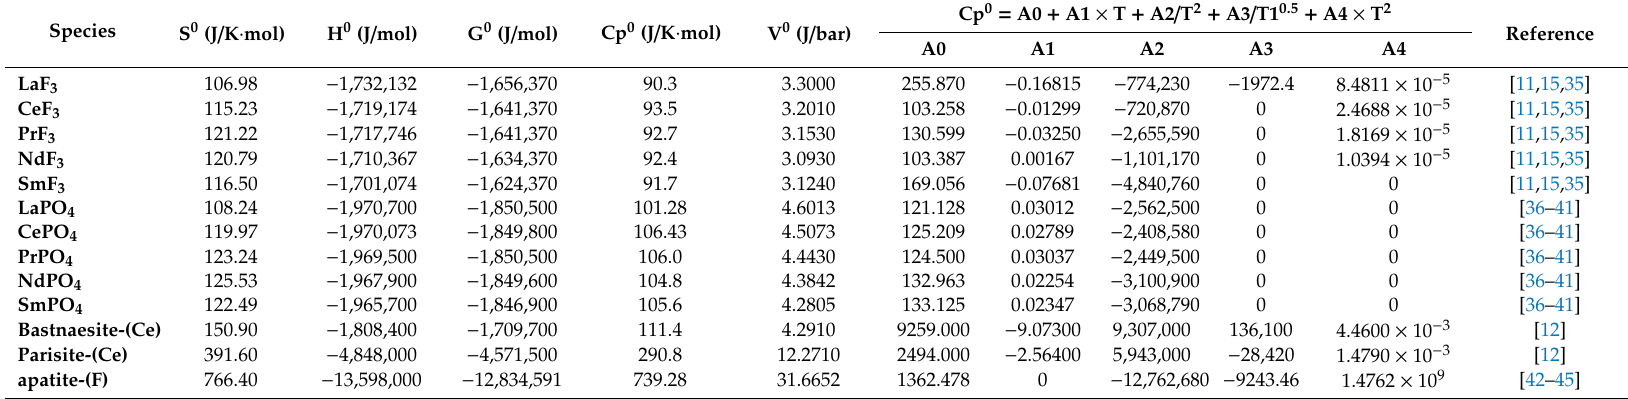
Table 1. Standard thermodynamic properties of REE minerals that are added into the modified MINES